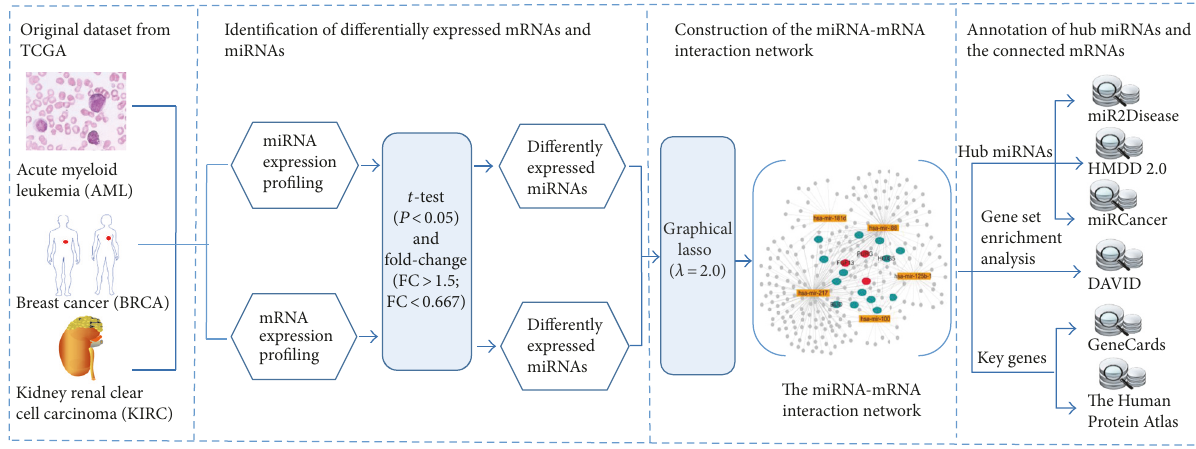
Figure 1: The overview of the study design. Table 1: The annotation of the top 20 miRNAs in